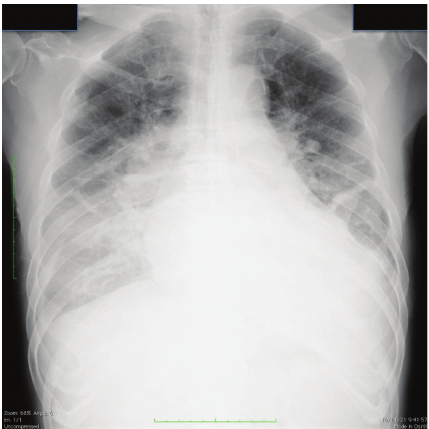
Figure 1: Chest X-ray at admission: significant pulmonary conges- tion and reduced bilateral lung permeability due to pleural e ff usion were seen (cardiothoracic rate of